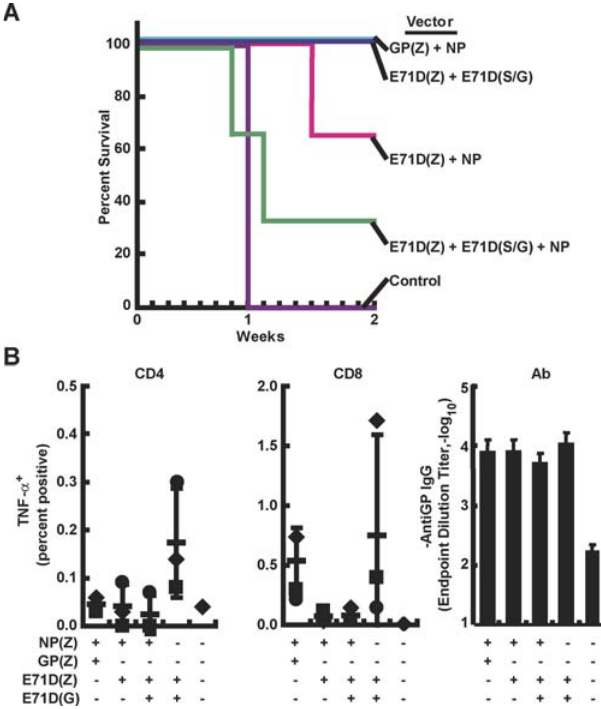
Figure 5. Comparative Efficacy of Wild-Type and Point Mutant Glycoprotein Vaccines against Lethal Ebola Virus Challenge (A) Kaplan-Meier survival curve of macaques: Immunization and challenge were performed with the Kikwit strain ebolavirus as in Figure 2A. (B) Immune responses in immunized animals. Left and middle graphs: Intracellular flow cytometry was performed to quantify TNF- a production from Ebola-specific CD4 þ or CD8 þ lymphocytes, respectively, from animals immunized as indicated. Immune responses were measured at 3 wk postimmunization. Circles, diamonds, and squares indicate responses for individual animals. Horizontal line indicates average of individual responses in the immunization group. Results represent the percent cytokine positive in the gated lymphocyte group, and back- ground stimulation (DMSO alone) has been subtracted from each sample. ELISA titers of Ebola GP-specific antibodies in sera of vaccinated animals collected at week 3 postimmunization (right graph). ELISA results represent endpoint dilution titers determined by optical density as described in Methods. DOI: